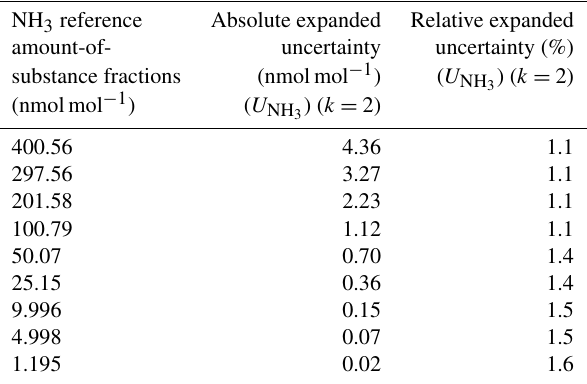
Table 7. The uncertainty budget of the NH 3 amount-of-substance fractions used as calibration values. The coverage factor ( k ) is indi- cated for the absolute and the relative expanded uncertainties.